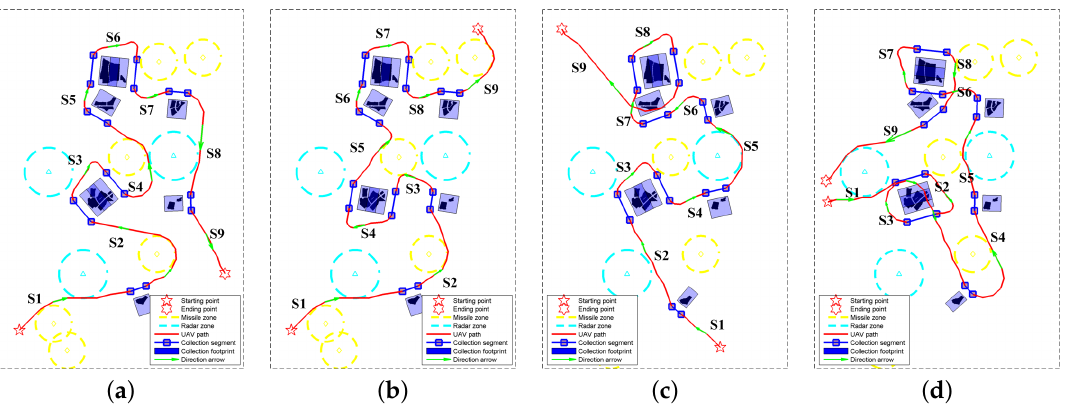
Figure 14. Paths designed by the proposed path planners. ( a ) test case 1; ( b ) test case 2; ( c ) test case 3; ( d ) test case